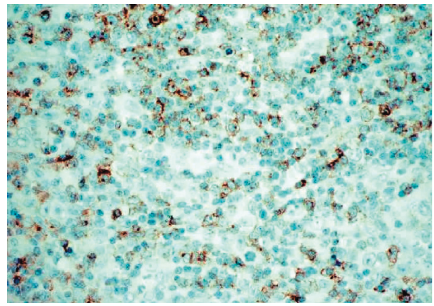
Figure 5: Inguinal lymph node CD4+ stain.